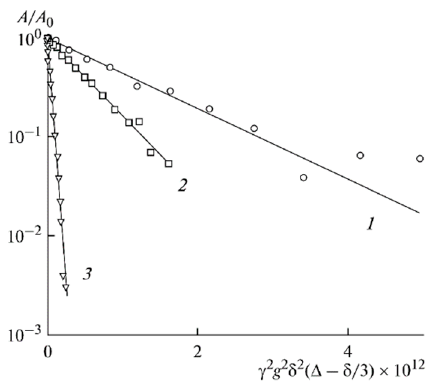
Figure 10. Dependences of the 7 Li spin-echo signal amplitudes on the square of magnetic field gradient amplitude (diffusion decay) for PGE samples: ( 1 ) no. 2, ( 2 ) no. 5, and ( 3 ) no. 9 [53].